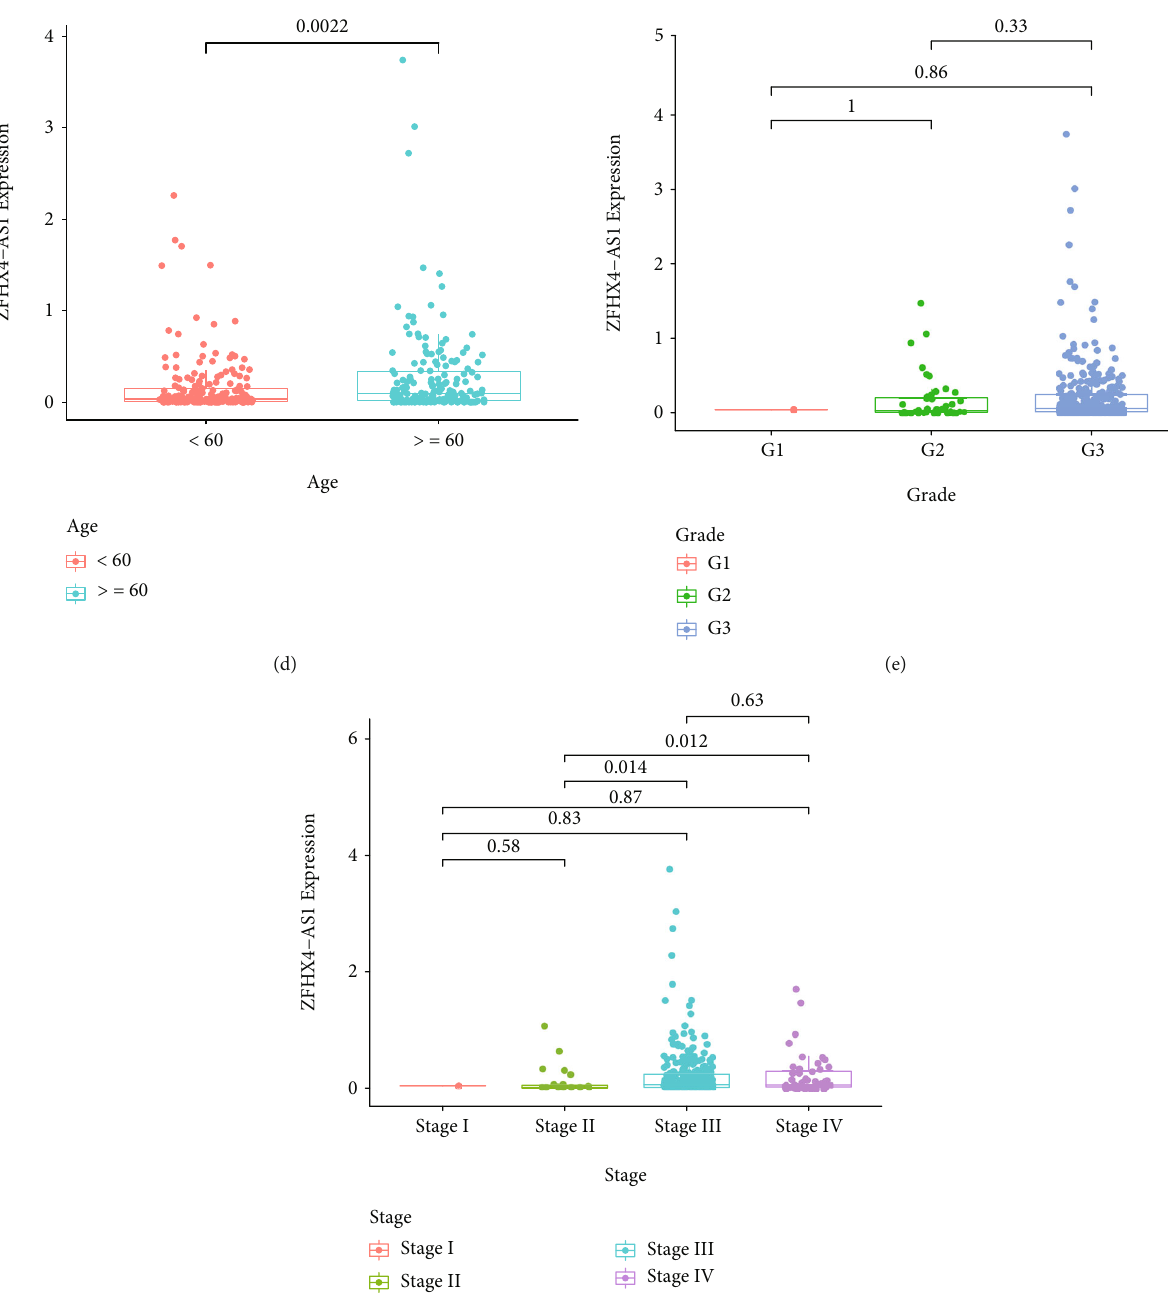
Figure 1: The expression of ZFHX4-AS1 in OC and clinical signi fi cance. (a) Kaplan – Meier survival curves for ZFHX4-AS1 based on TGCA datasets. (b) ZFHX4-AS1 expression in 374 OC specimens and 180 nontumor specimens. (c) The expression of ZFHX4-AS1 in 53 tumor samples and 10 nontumor samples from GSE18520. The relationships between ZFHX4-AS1 and clinical features, including (d) age, (e) grade, and (f) stage. ∗∗∗∗ P < 0 : 0001 and ∗∗ P < 0 : 01